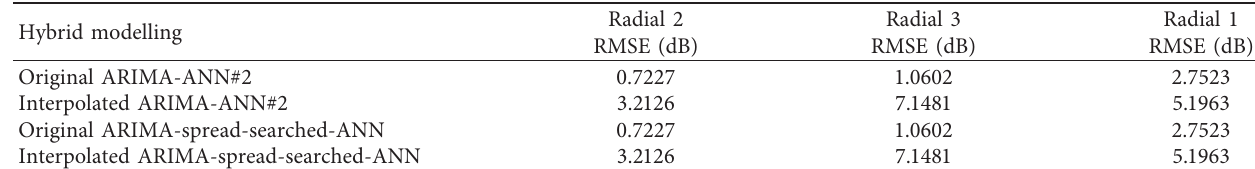
Figure 8: ANN#2 diagram [14]. Table 3: RMSE values for ANN#2 and spread searched ANN